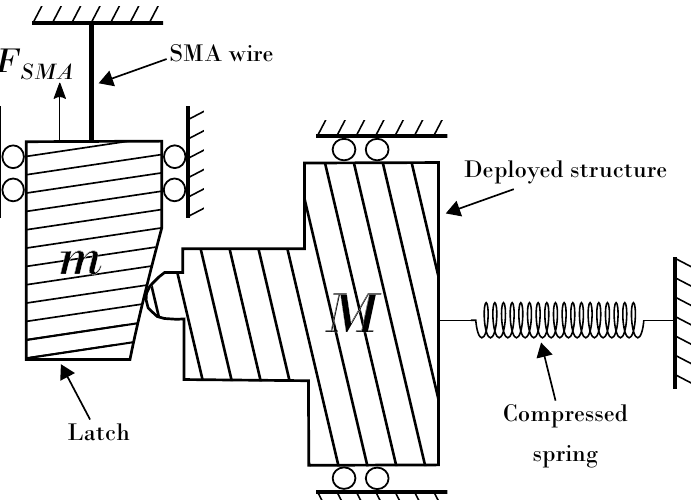
Figure 1. Schematics of a conceptual tablecloth-trick latch mechanism, based on fast SMA actuation, designed to reduce the required work output. The friction force at the contact between the deployed structure (large mass), M , and the latch (small mass), m , is greatly reduced by disengaging the masses as result of rapid actuation, compared with slow release